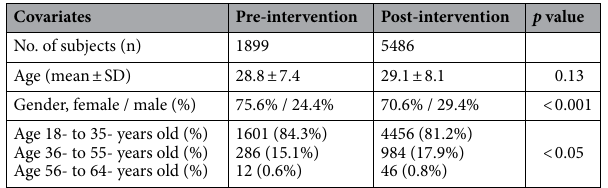
Table 1. Cohort characteristics, stratified into pre-and post-intervention periods.